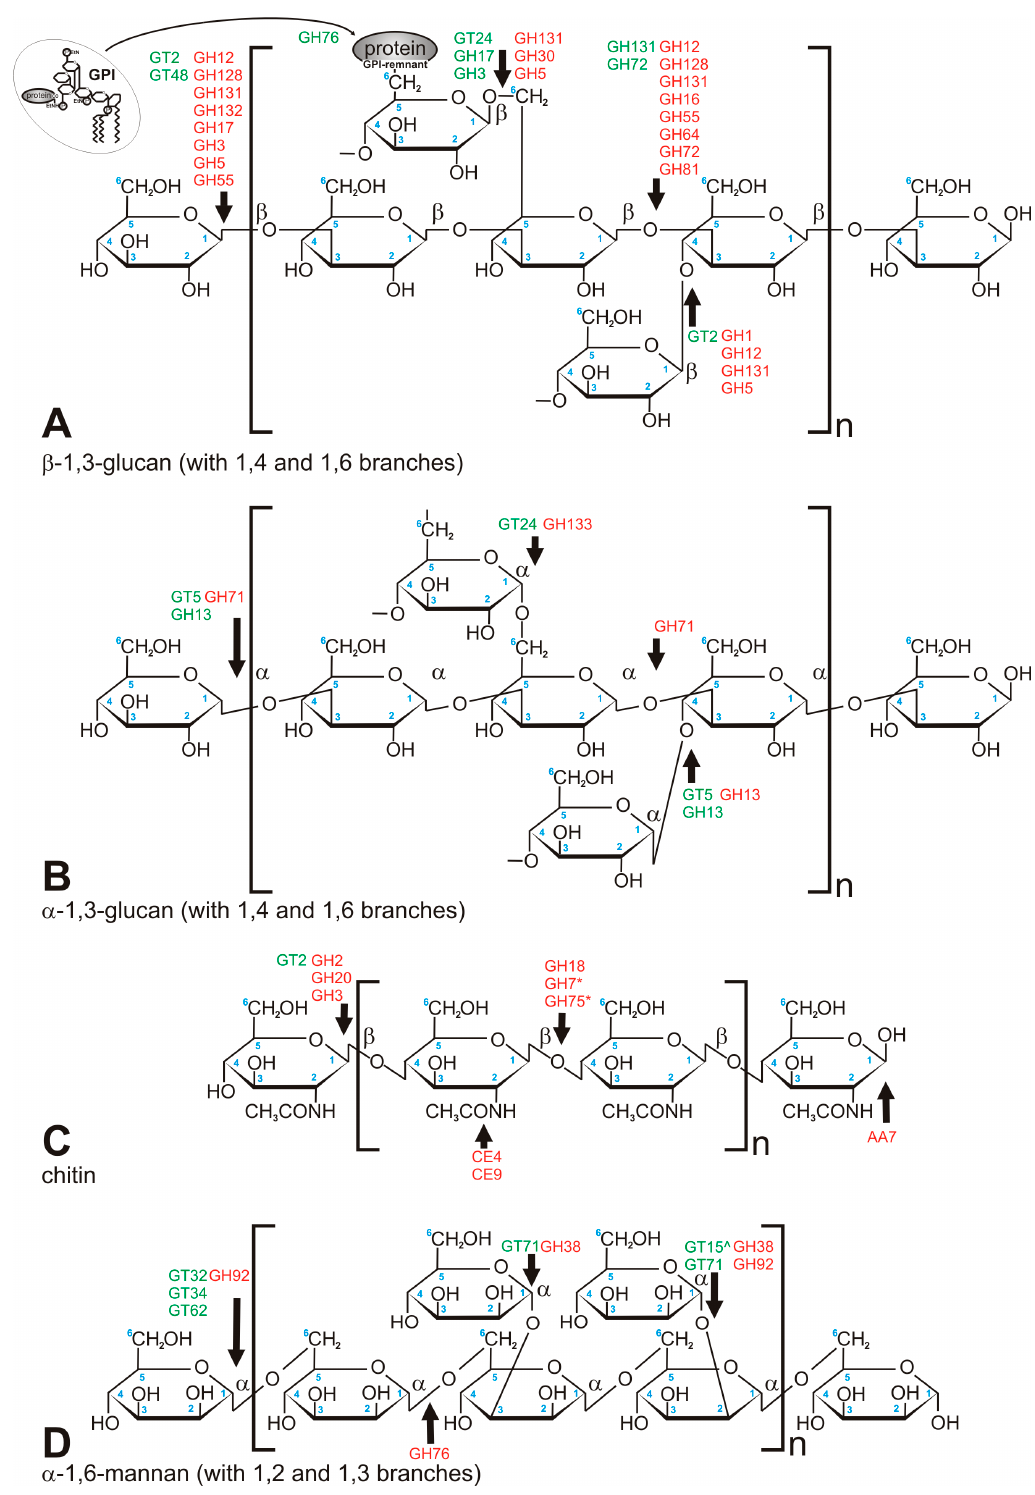
Figure 2. Major carbohydrate polymers which build fungal cell wall. ( A ) β -1,3-glucan (crosslinked via 1,4 and 1,6 chain branches); ( B ) α -1,3-glucan (crosslinked via 1,4 and 1,6 chain branches); ( C ) chitin; ( D ) mannan, mostly found in Saccharomycetales. Green font refers to anabolic